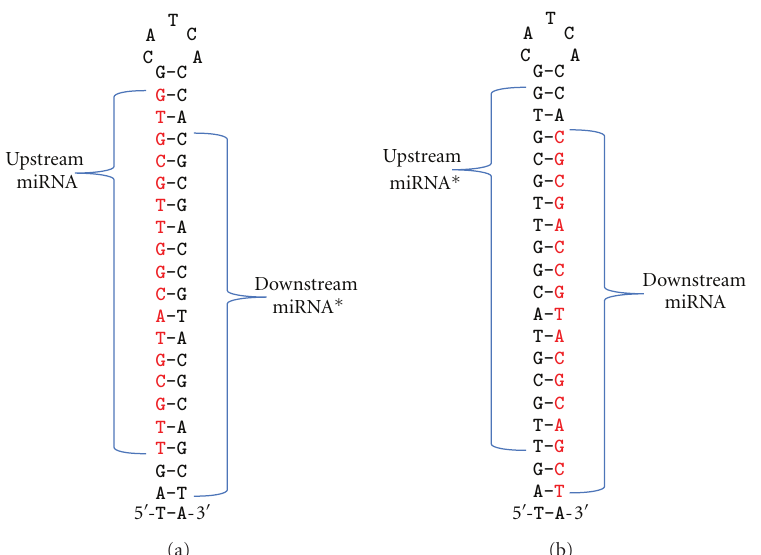
Figure 2: (a) Example of an upstream miRNA with downstream miRNA ∗ . (b) Example of a downstream miRNA with upstream miRNA ∗ . The mature miRNA (in red) may exist within the precursor upstream of the miRNA ∗ (a) or downstream (b). Determining this location is critical for collecting the appropriate attribute set.